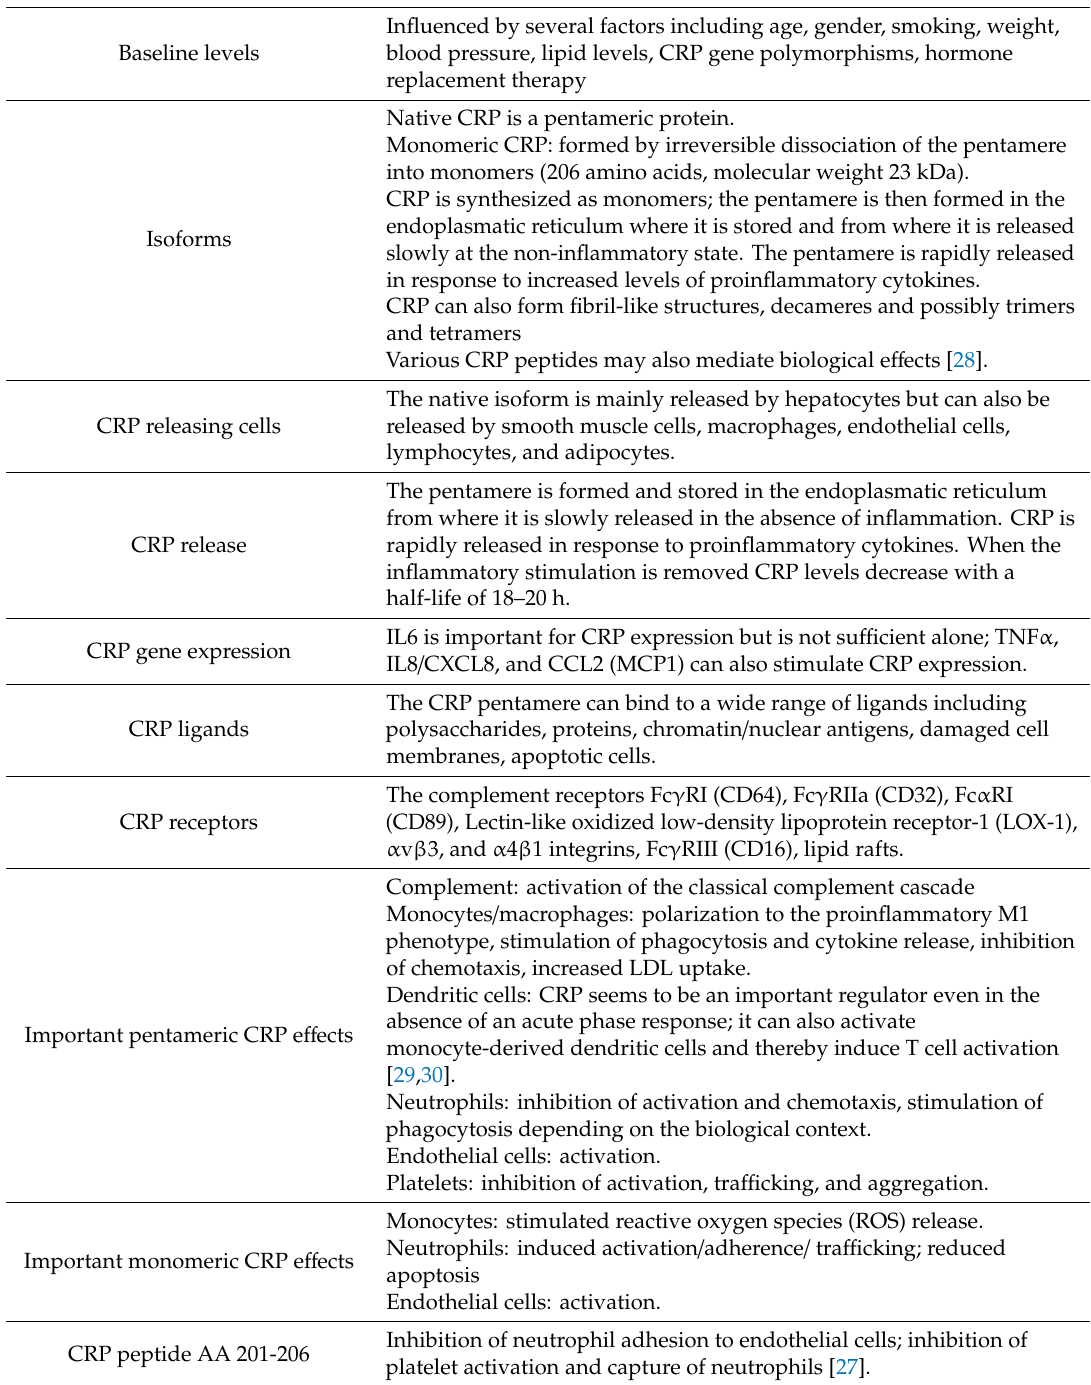
Table 2. A summary of important molecular and biological characteristics of CRP. For more detailed information and additional references, we refer to several recent review articles [7,9,26,27]; additional original articles describing specific observations are given in the table 1